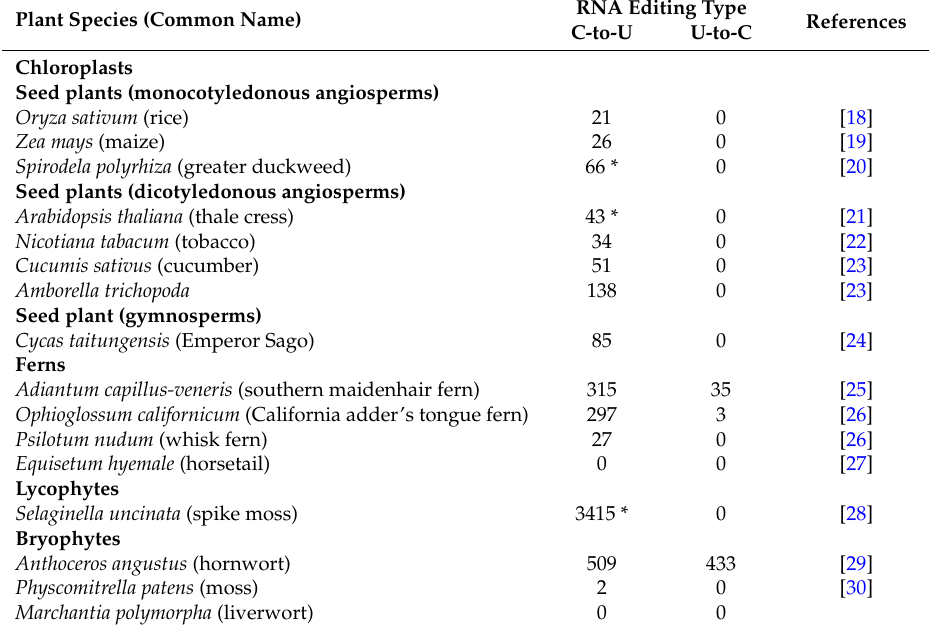
Table 1. The numbers of RNA editing sites in chloroplasts and plant